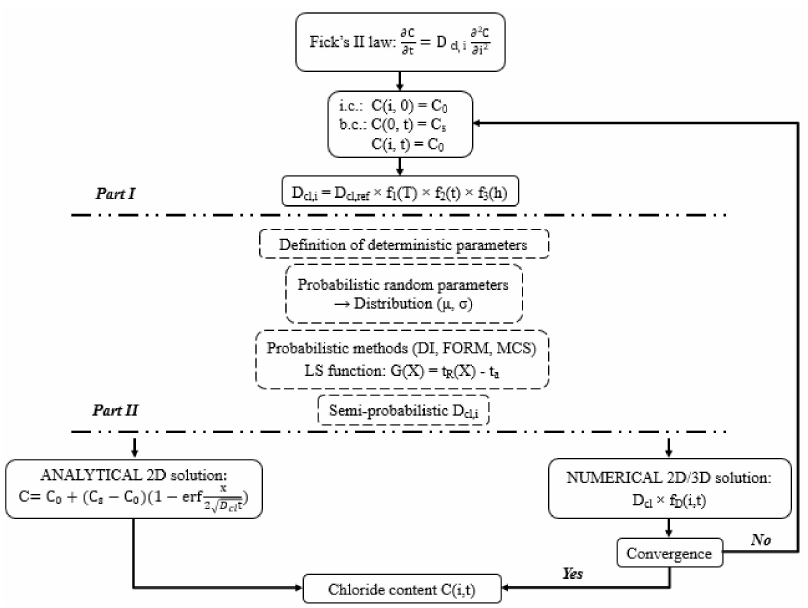
Figure 2. Flowchart of the general